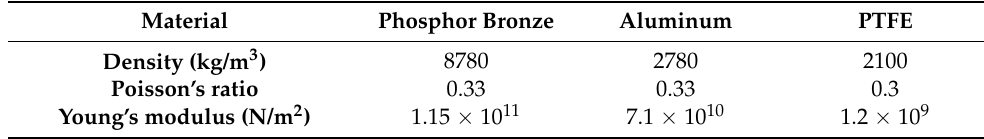
Figure 6. 3D finite element model of the traveling wave LUSM. Table 1. Constants of the common materials.